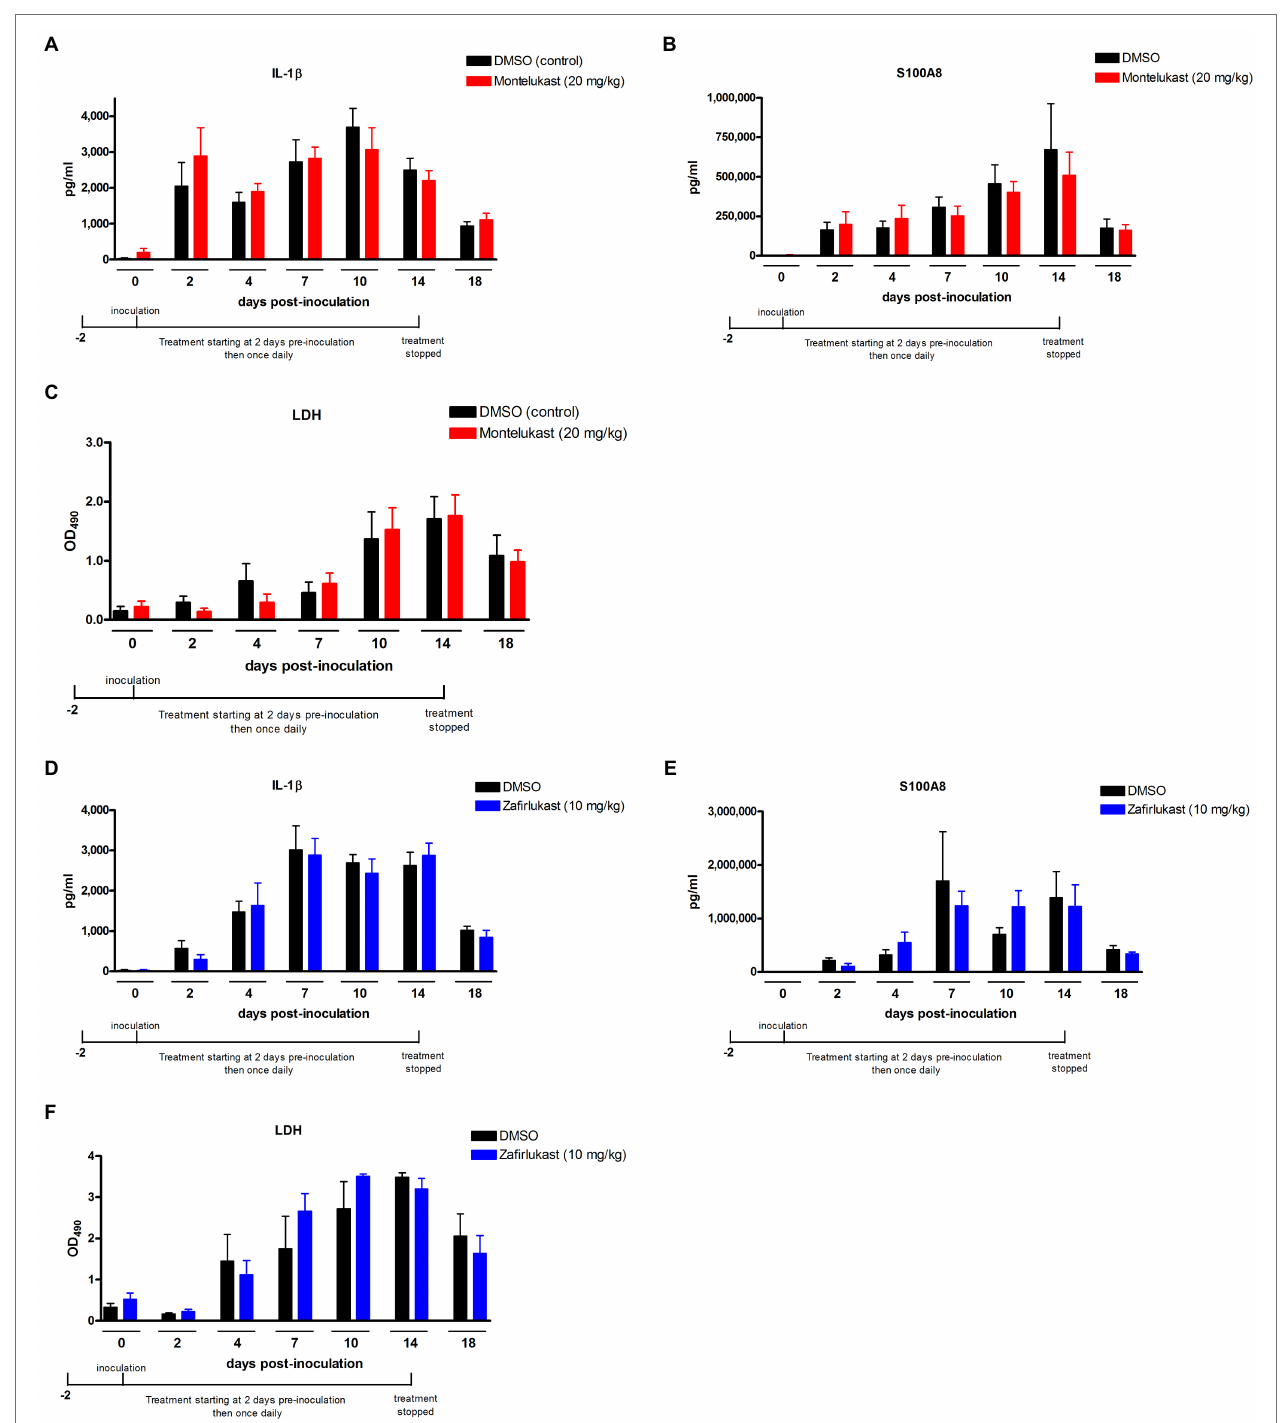
FIGURE 3 | Treatment with leukotriene receptor antagonists does not alter the production of inflammatory mediators and vaginitis-associated tissue damage in the vaginal mucosa following inoculation with C. albicans. Estrogenized C3H mice were administered Zafirlukast (10 mg/kg), Montelukast (20 mg/kg) or vehicle alone (10% DMSO) in a volume of 100 μ l by i.p. injection on 2 days prior to inoculation then once daily for 16 days. Mice were intravaginally inoculated with 5 × 10 4 C. albicans 96,113. Vaginal lavage fluid was collected longitudinally over a period of 18 days post-inoculation. Levels of (A,D) IL-1 β and (B,E) S100A8 in vaginal lavage fluid were quantified by ELISA over a period of 18 days post-inoculation. (C,F) LDH release in vaginal lavage fluid was measured as an indicator of tissue damage. Data represent cumulative results of 2 independent experiments performed with 4–10 animals/group. Data were analyzed by using the unpaired Student’s t test comparing the drug-treated groups with vehicle control group at specific time points. LDH, lactate